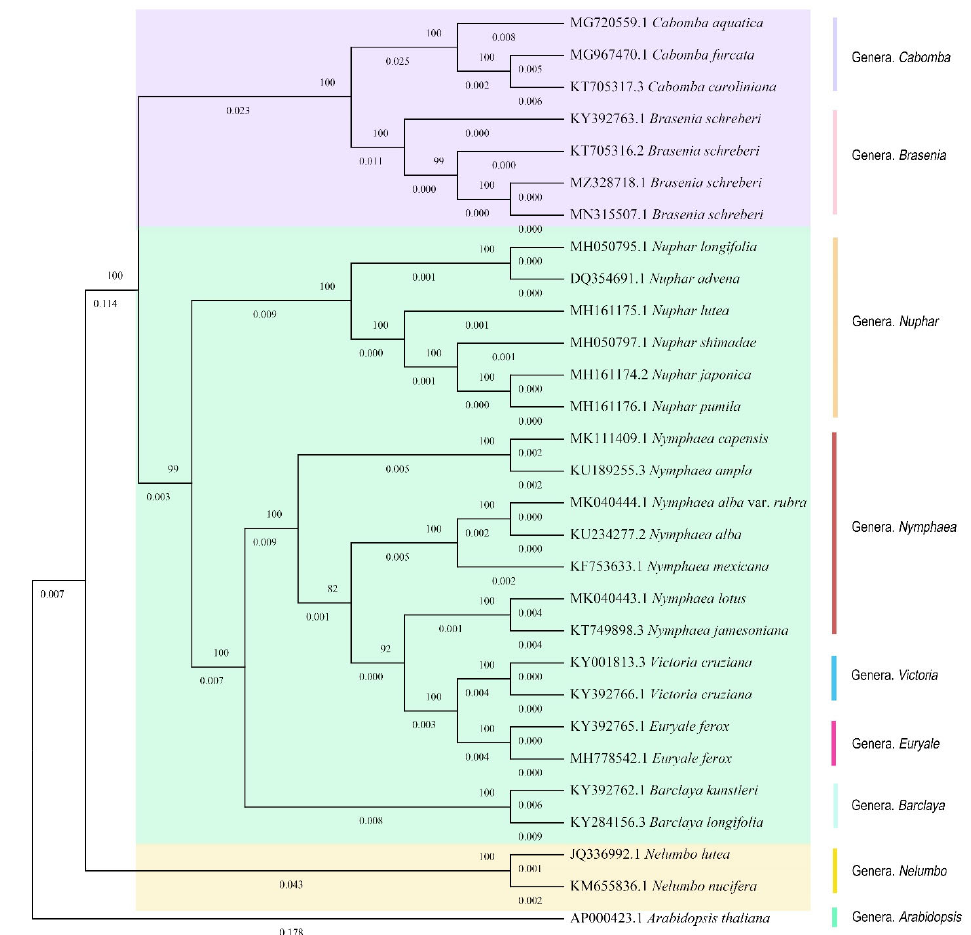
Figure 9. Maximum likelihood evolutionary tree of 29 species. The cp genome sequence of Arabidopsis thaliana (AP000423.1) was used as outgroup to root the trees. Number beyond each branch indicates the bootstrap support value. Three colored lines represent three families analyzed phylogenetic relationship, Nymphaeaceae, Cabombaceae and Nelumbonaceae. Nine colored lines indicate the nine genera.